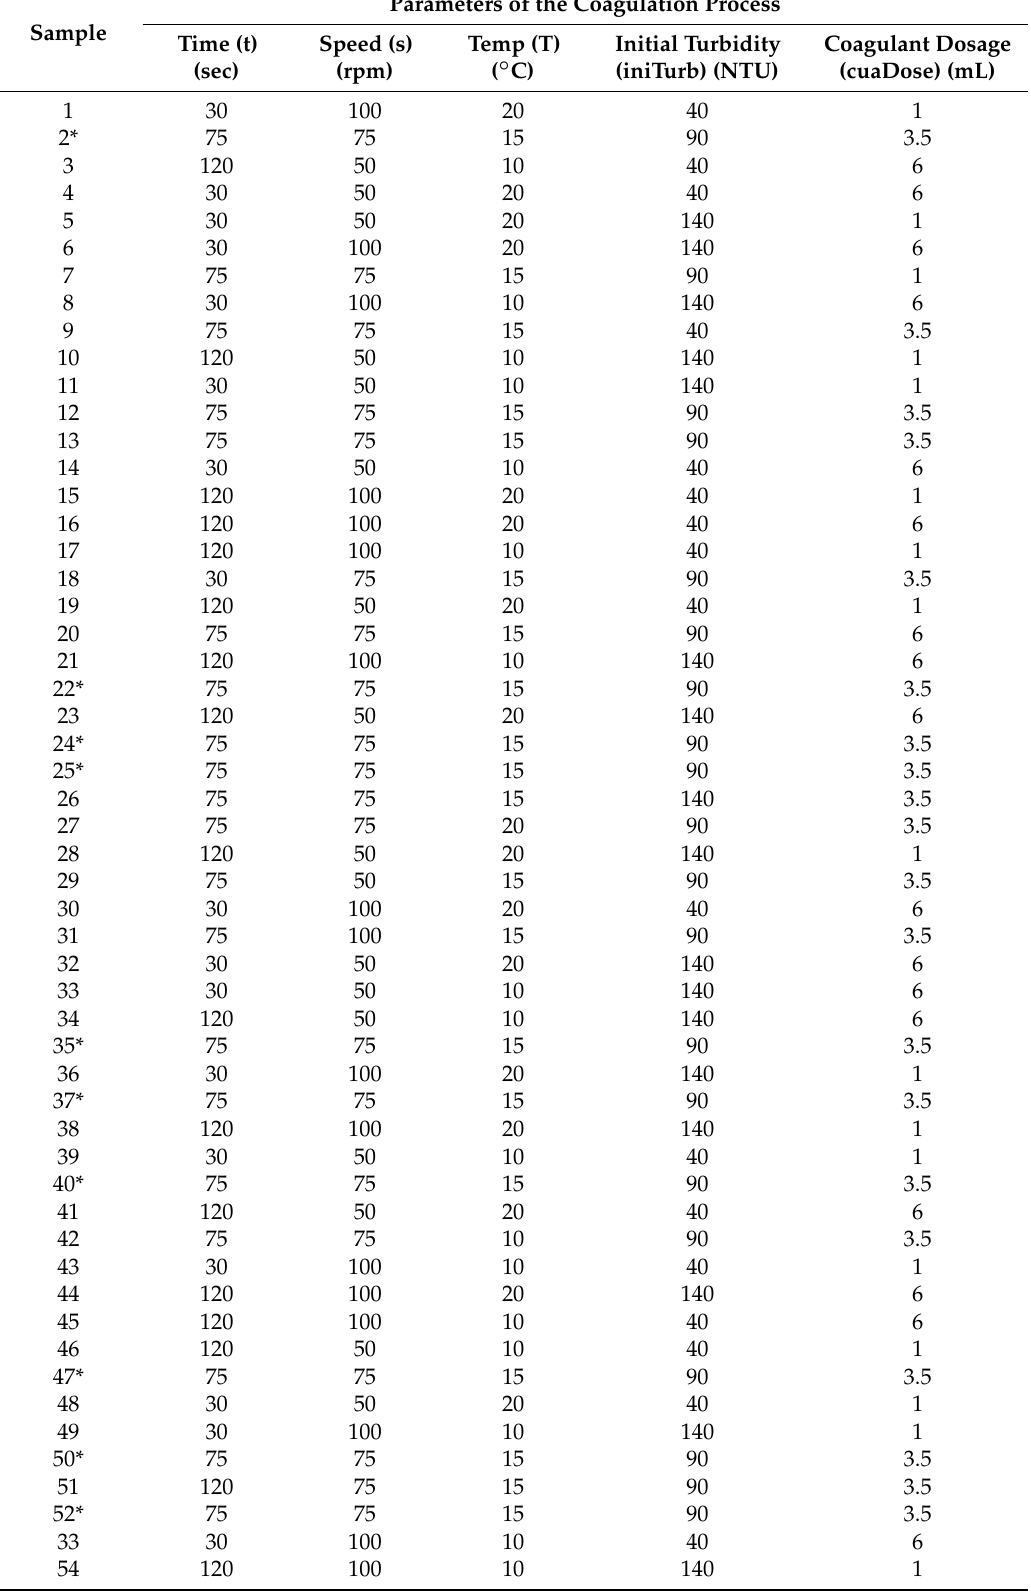
Table 3. Design matrix for clarification of waste